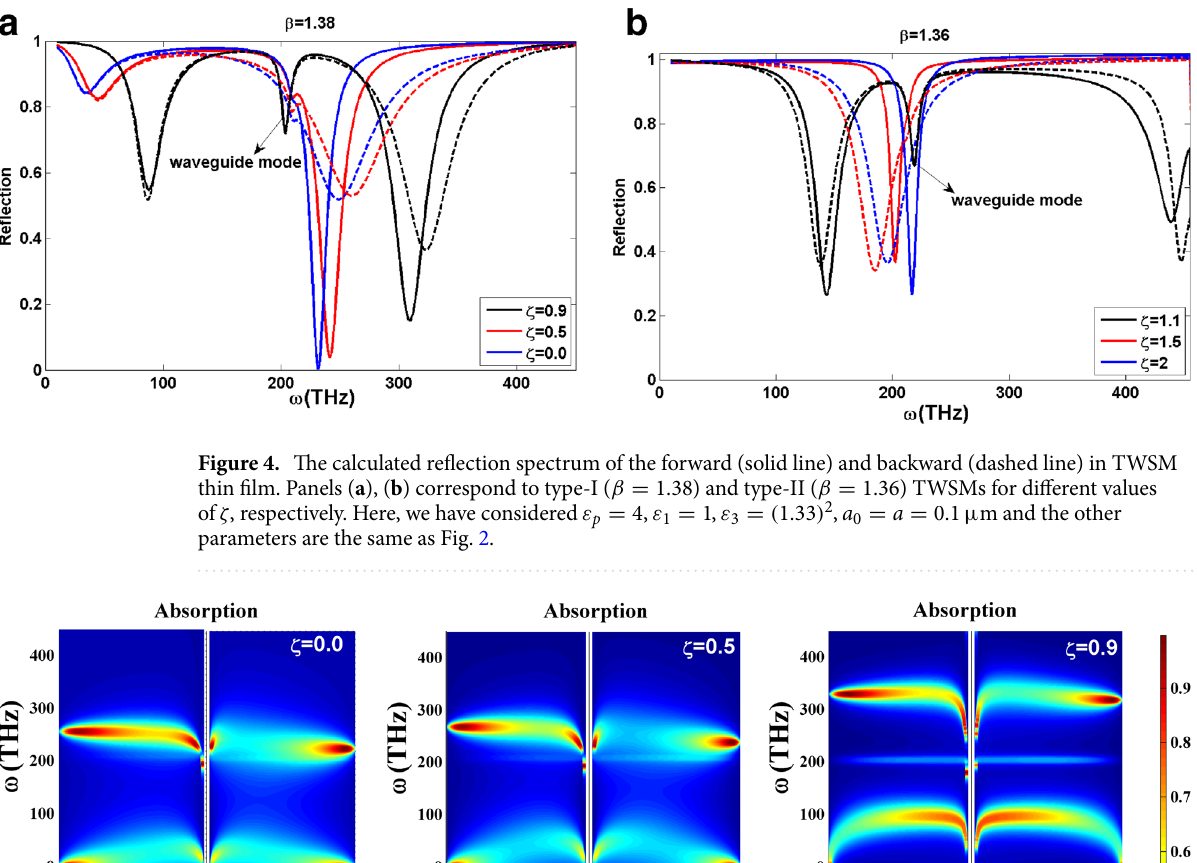
1.38 ) and type-II ( β 1.36 ) TWSMs for different values = =